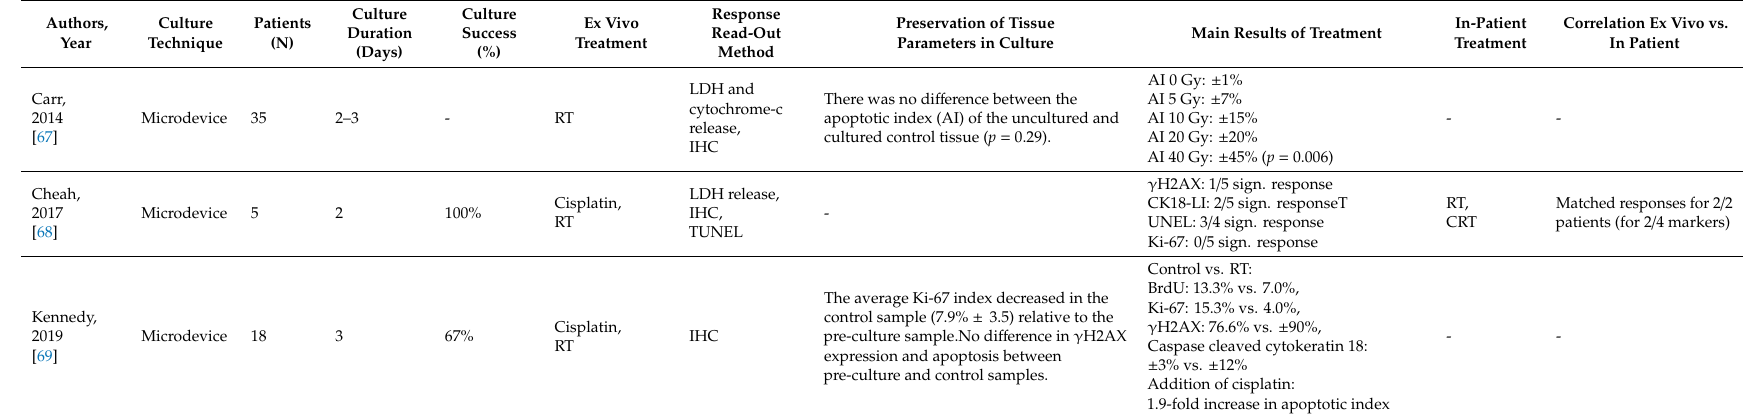
Main Results of Treatment In-Patient Treatment Correlation Ex Vivo vs. In Patient